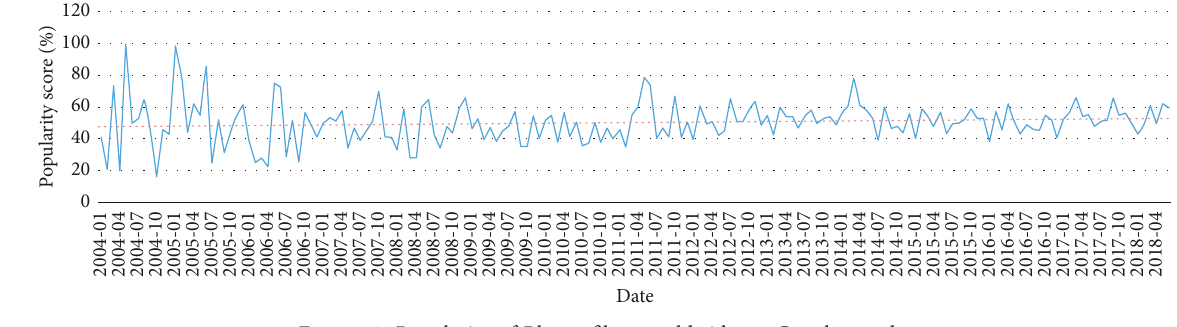
Figure 2: Popularity of Bloom filter worldwide on Google